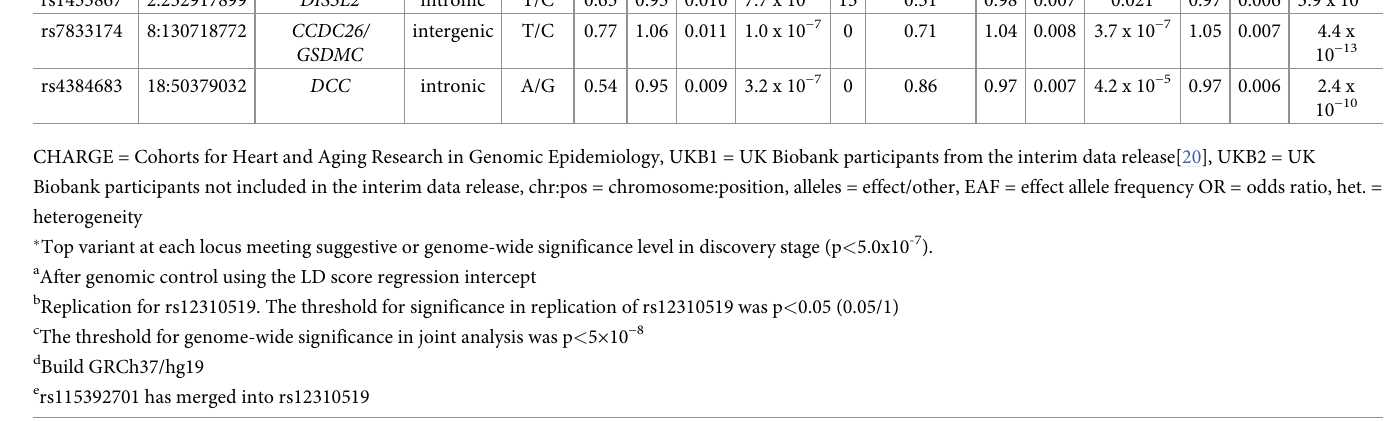
Replication (UKB2) b Joint Meta-Analysis (n = 283,752) (Discovery- Replication) c (n =